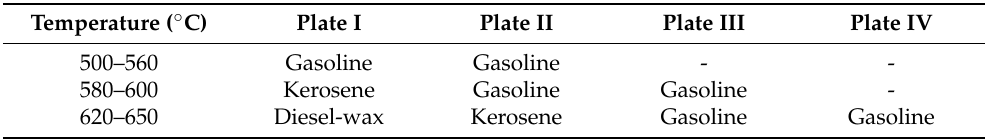
Table 7. Distribution of fuel products along the column